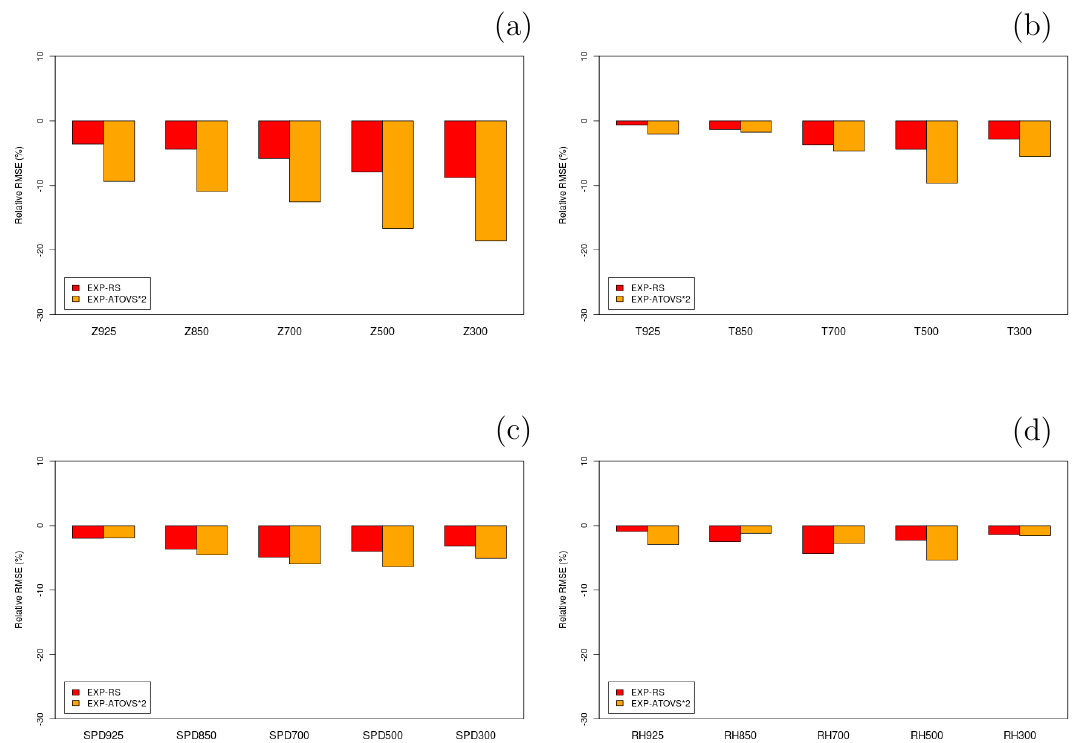
Fig. 6. Relative RMSE (%) of 925, 850, 700, 500 and 300hPa geopotential height (a) , temperature (b) , wind speed (c) and relative humidity (d) forecasts for data targeting experiments EXP-RS and EXP-ATOVS*2 for 2008 and 2009 cases.